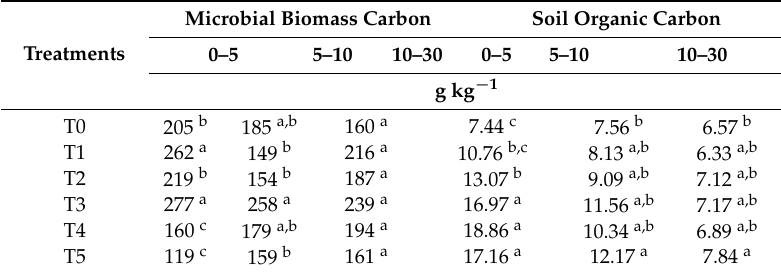
Table 1. Microbial biomass carbon (MBC) and soil organic carbon (SOC) of topsoil (0–30 cm) at harvest in 2015, at Dingxi experiment station,